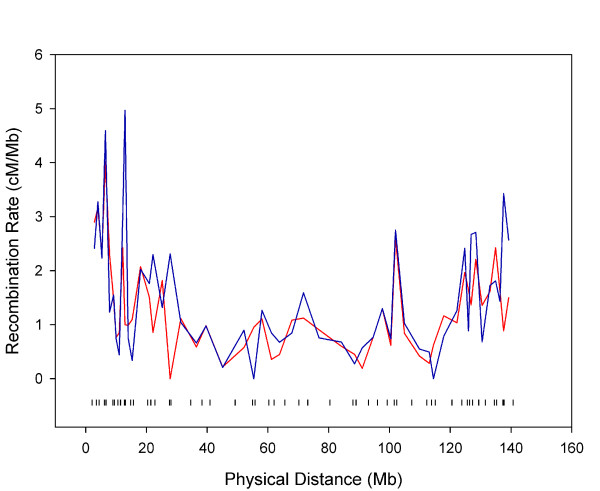
Comparison of sex-averaged recombination rates of chromosome 8 between the GENDISCAN map (red line) and Rutgers Map v.2 (blue line). The physical positions of genetic markers are denoted by black vertical marks.